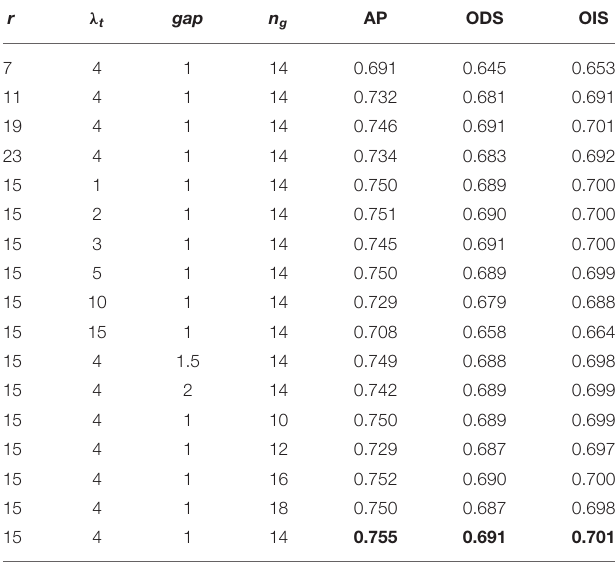
TABLE 6 | Parameters ablation of our label correction